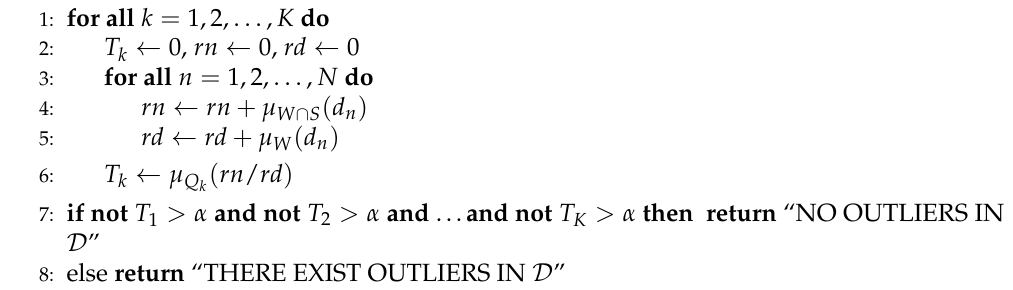
Algorithm 2 Detecting outliers via the second form of linguistically quantified